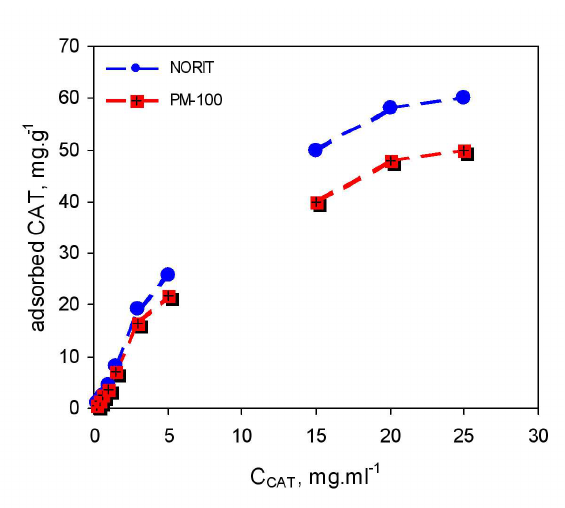
Fig. 1 Dependence of the amount of the adsorbed catalase on the start enzyme solution con- centration at constant temperature 24 ± 1 ◦ C; pH=11.21 on the adsorbents: activated carbon NORIT (blue), carbon black PM-100 (red). The tentative trend of the dependence is ploted with dashed lines in the respective